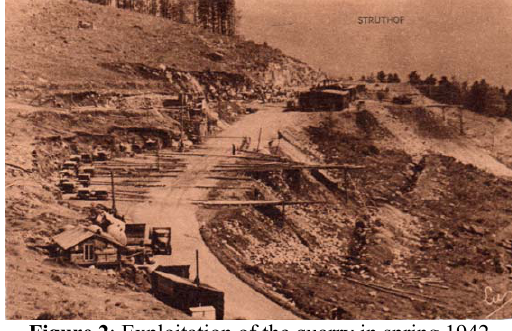
Figure 2 : Exploitation of the quarry in spring 1942 (Postcard ed. Lucien Kohler, CERD).